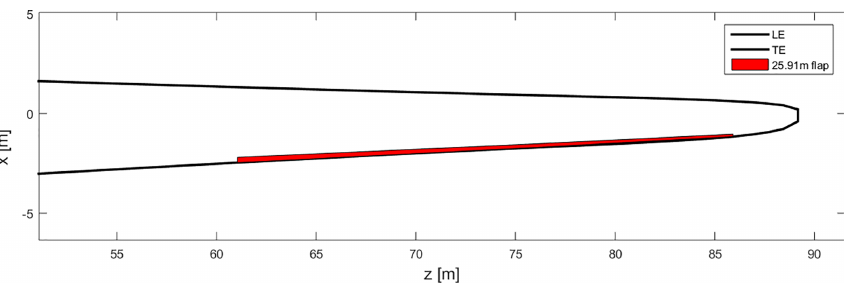
Figure 4. Flap placement.